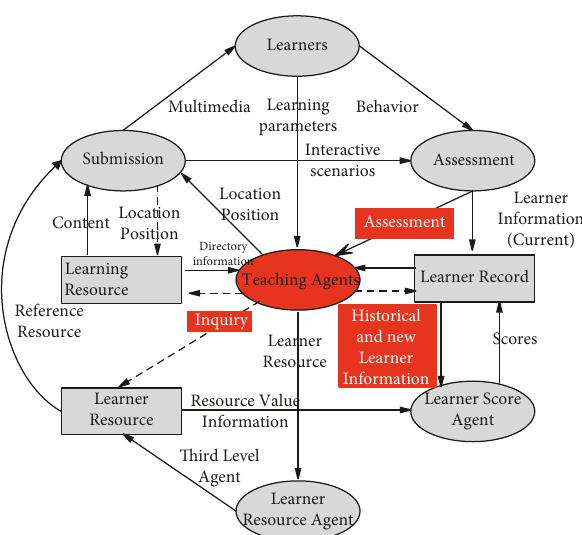
Figure 3: Data structure MOOC learning management framework.